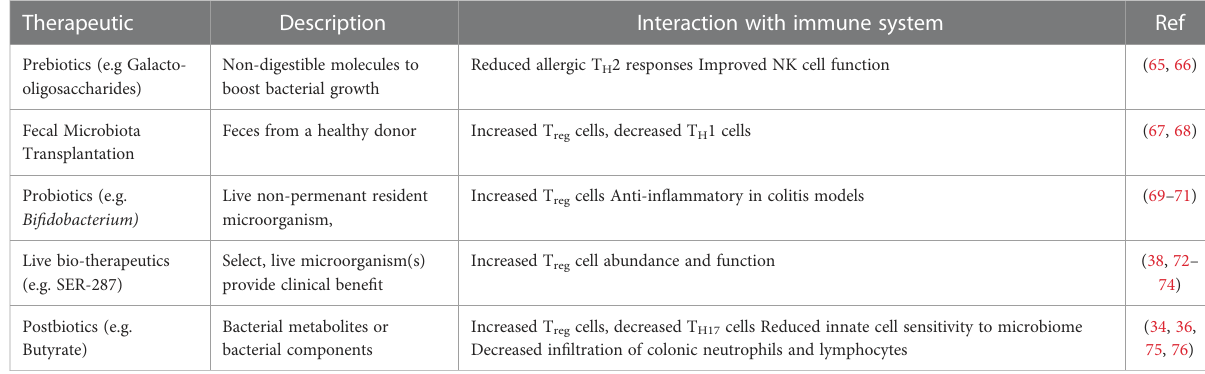
TABLE 1 Categories of microbiome-based therapies.